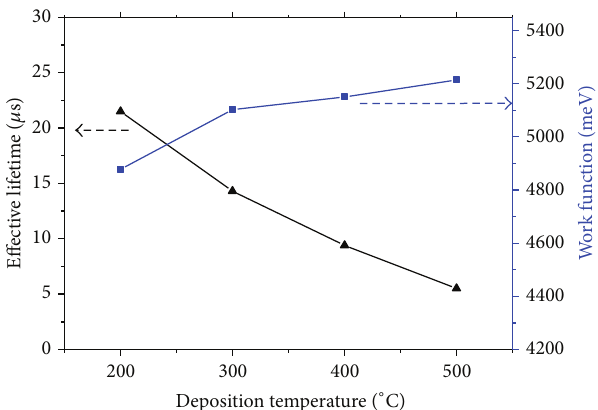
Figure 7: Work function ( ◼ ) and effective lifetime ( 󳵳 ) of TiO 2 thin films at different deposition